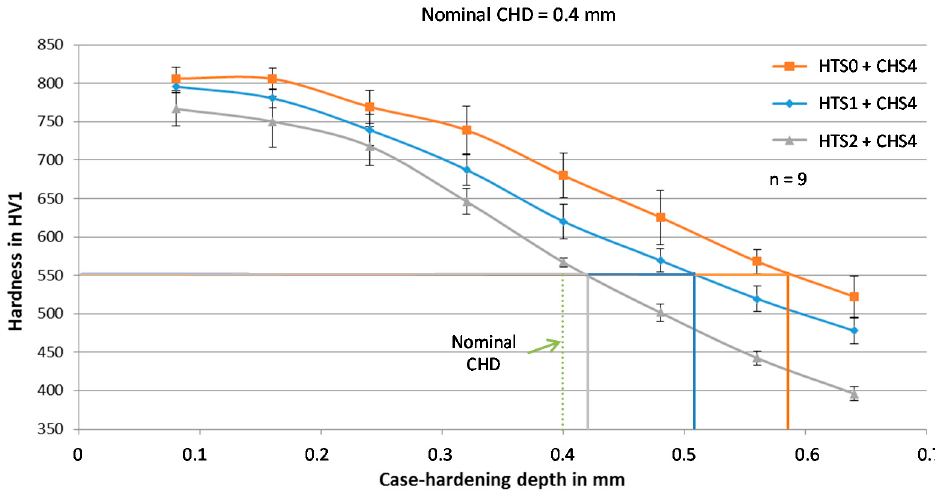
Figure 8. Effect of different heat treatment strategies on CHD and the corresponding material hardness. HTS0 + CHS4 represents the as-built state without heat treatment, HTS1 + CHS4 is stress relief treated (680 °C, 2 h) before case hardening and HTS2 + CHS4 is the material exposed to coarse grain annealing (1050 °C, 6 h) prior to case hardening. Used additive manufacturing parameters: P L = 300 W; H = 40 µm, h = 120 µm, v s = 850 mm/s.